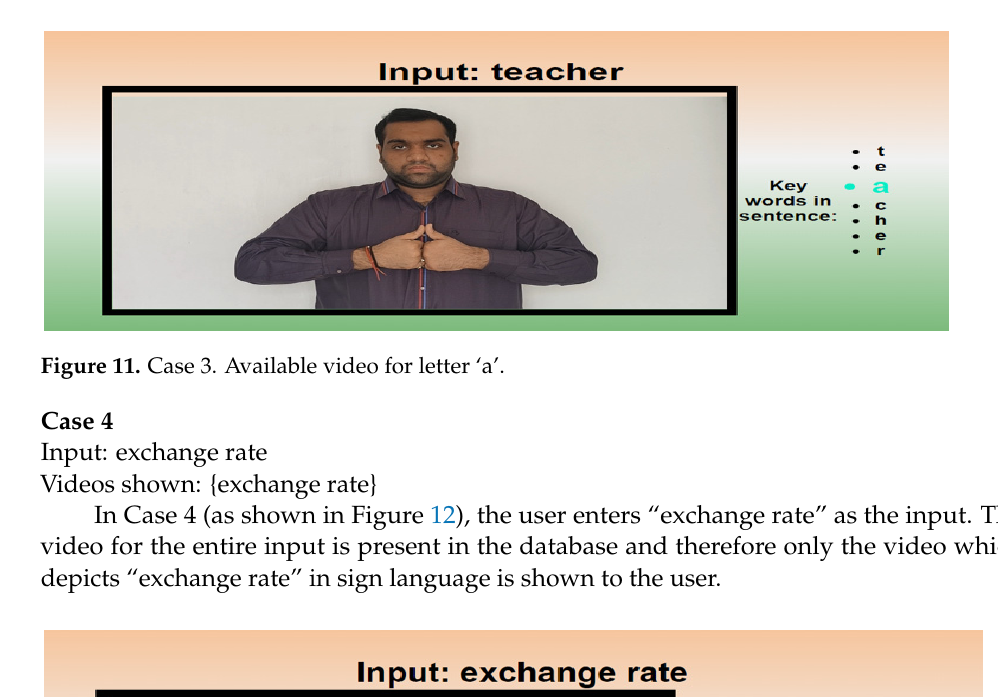
Figure 12. Case 4. Available video for ‘exchange rate’.